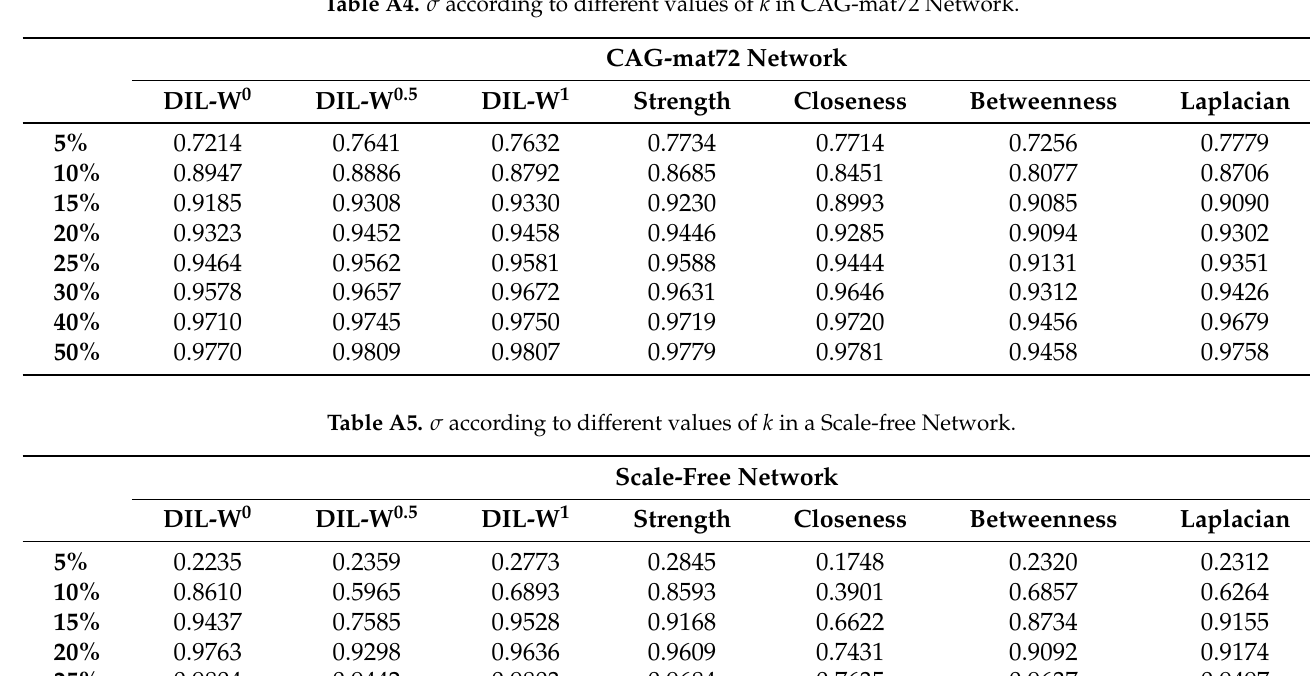
Table A4. σ according to different values of k in CAG-mat72 Network.